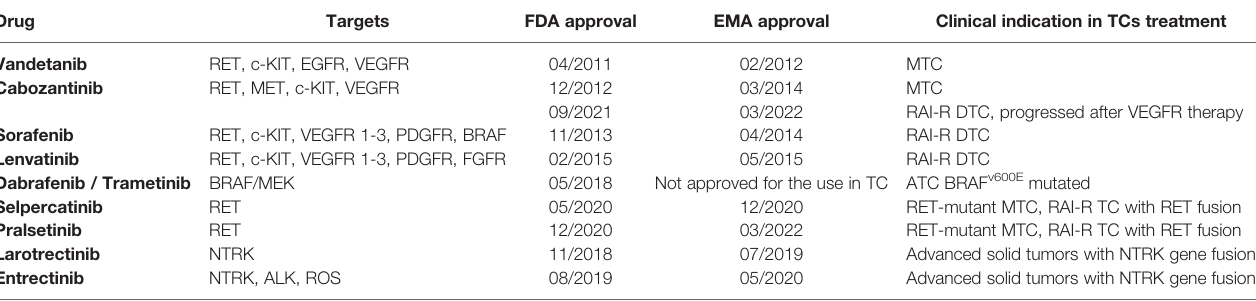
TABLE 2 | Tyrosine kinase inhibitors tested in thyroid cancers: the table summarize molecular targets of each compound and its label for the use in TCs in clinical practice. Drug